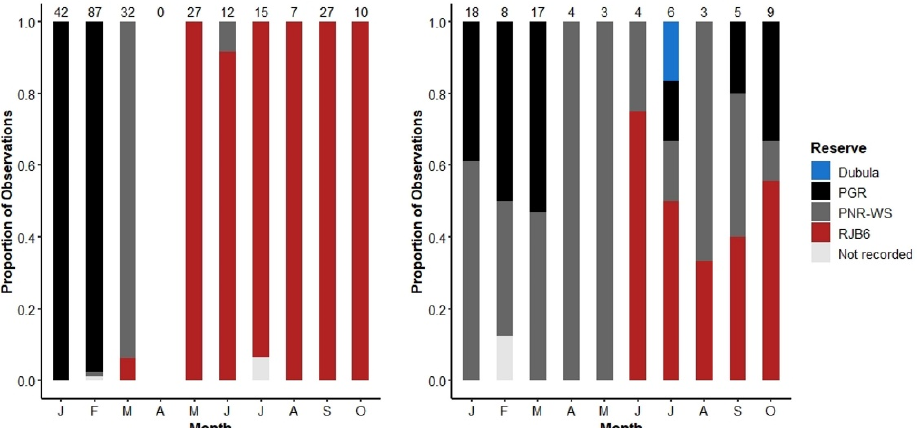
Figure 11. The movement of the A&B herd ( Left ) and Orphans ( Right ) during 2016. Bars indicate the proportion of observations in each reserve. For a map of the reserves, see Figure 1 and refer to the Methods section. Note that no observations were made of the A&B herd during April 2016.